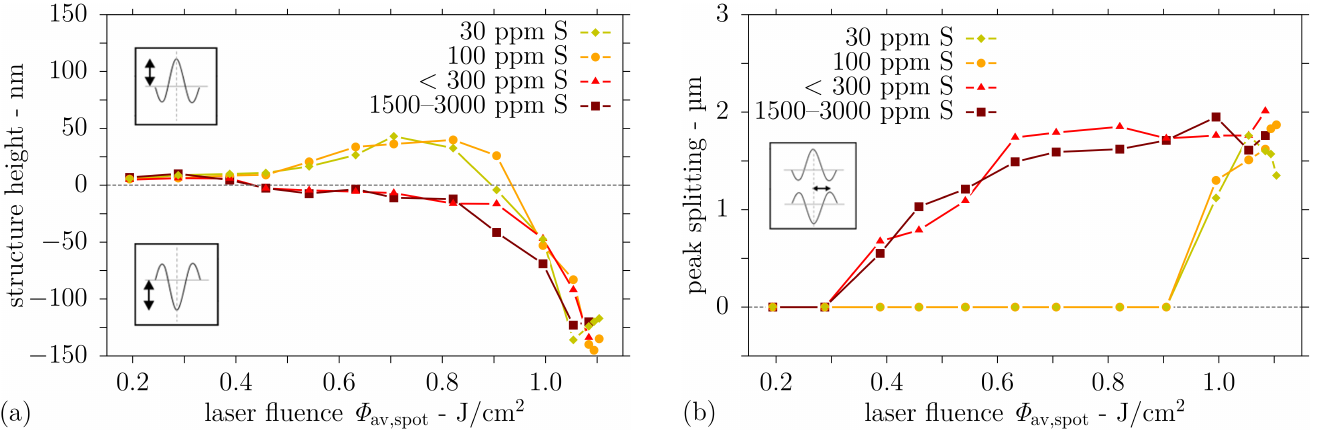
Figure 8. Surface topography observed after single pulse DLIP ( λ = 1053 nm, Λ = 7.2 µm, τ p = 12 ns) on steel with different sulphur contents as a function of fluence: ( a ) structure height and ( b ) distance of peak(s) from